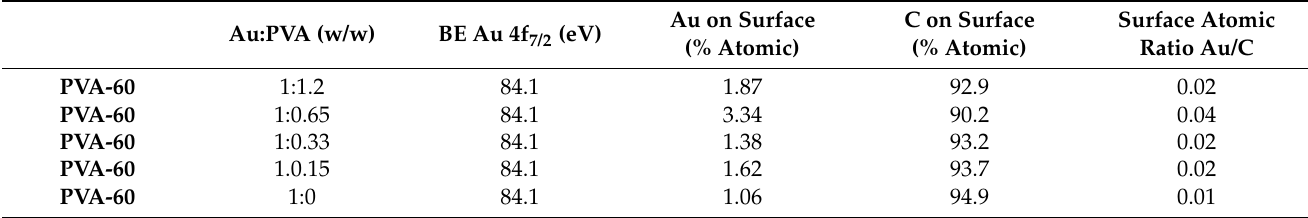
Table 12. XPS data for 1% wt. Au/AC synthesized using PVA-60 (derived form a PVAc Mn = 23,300) with different Au:PVA weight ratios.